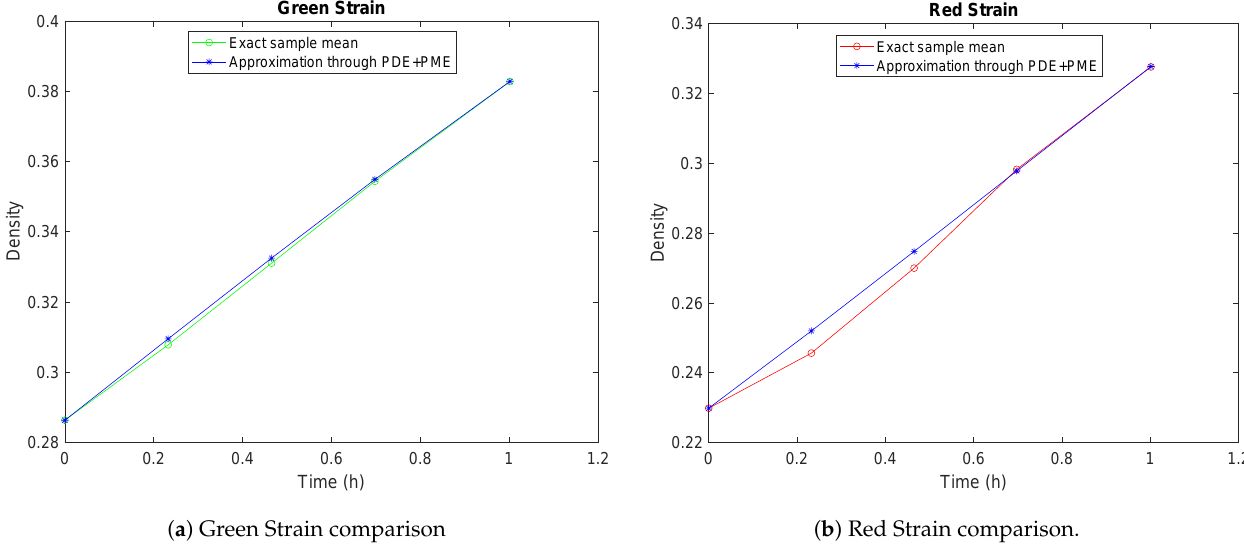
Figure 6. Visual comparison of the sample mean of each Strain data set from Table 1 with the mean computed by the procedure described in Section